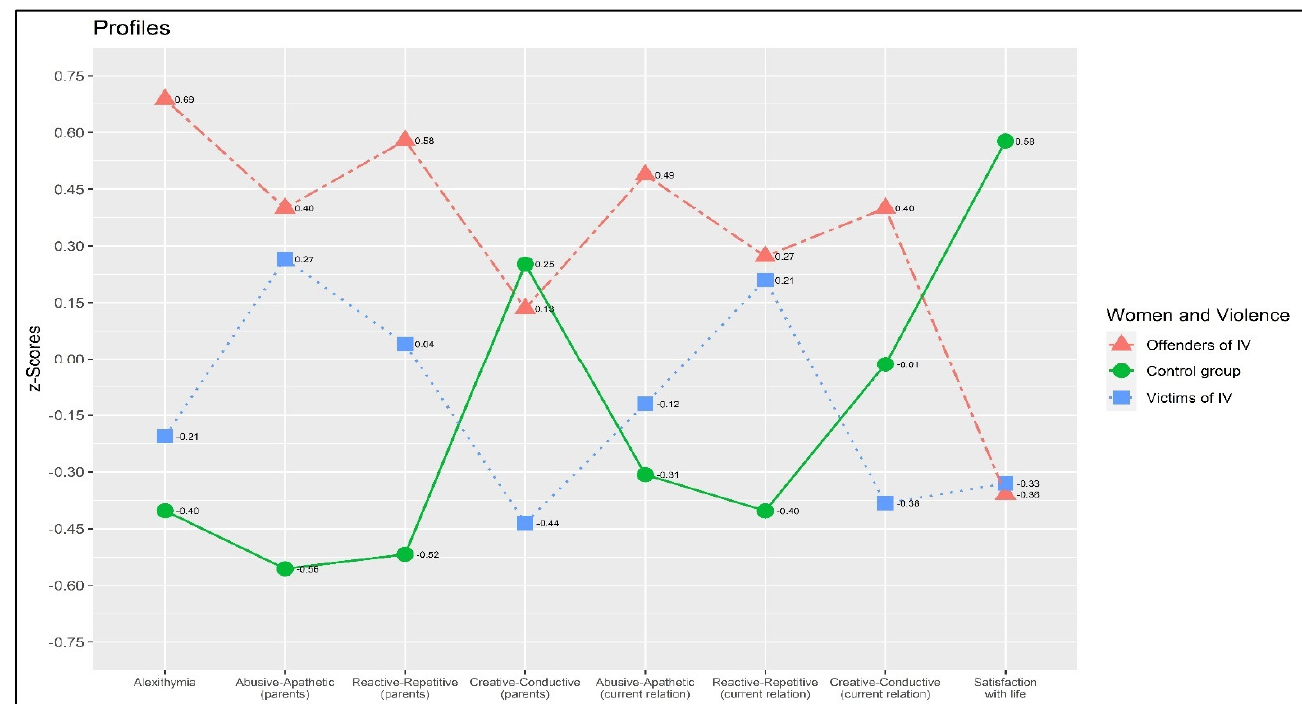
Figure 1 graphically represents the absence of parallelism.